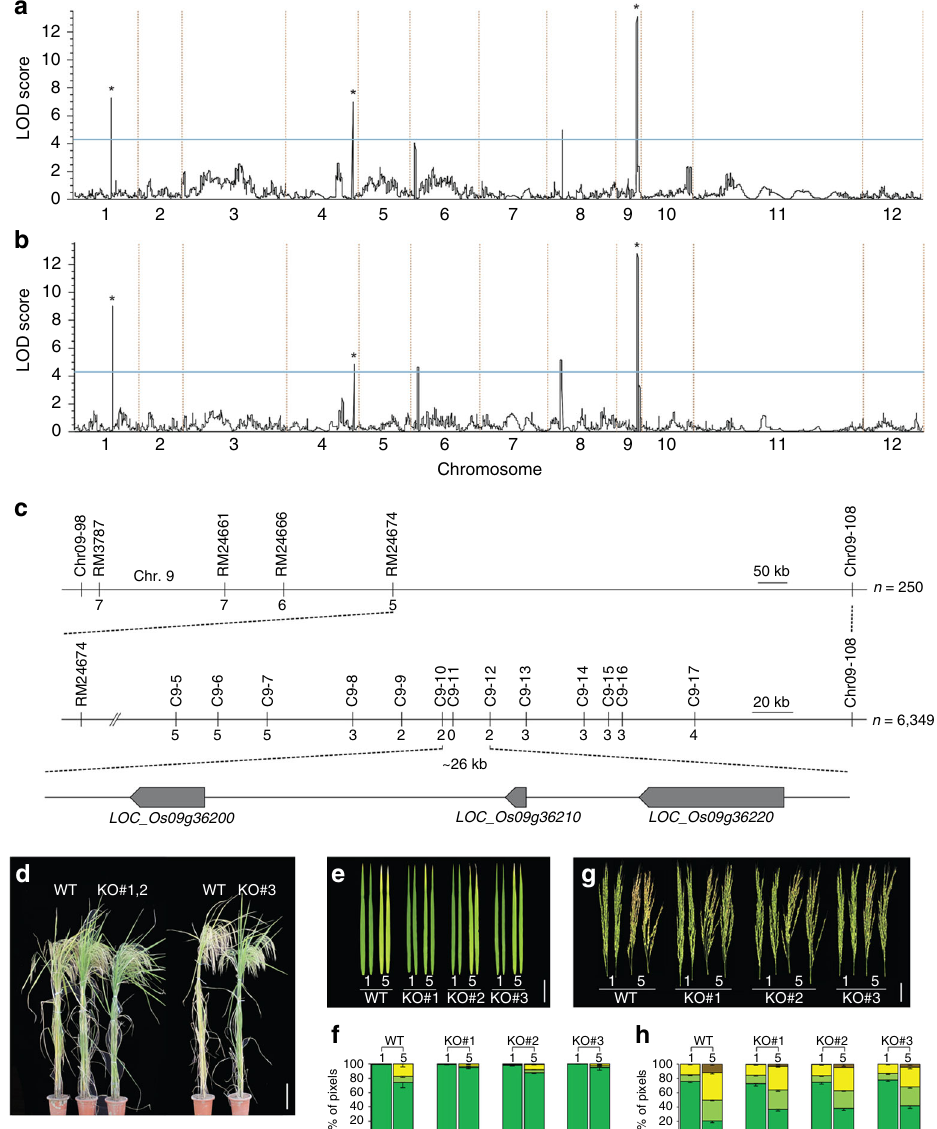
Fig. 2 OsSGR is responsible for the differential leaf senescence. Mapping curves of QTLs controlling the senescence of the fl ag ( a ) and second upper ( b ) leaves on the 12 rice chromosomes via GBS (genotyping-by sequencing). A LOD (log likelihood) signi fi cance threshold of 4.3 (blue lines) was used to declare the presence of signi fi cant QTL in a genomic region. Three common genetic loci between two leaves are indicated as *. c Fine mapping of the locus on the chromosome 9 for the leaf senescence with molecular markers. The 26-kb genomic region between C9 – 10 and C9 – 12 markers contains three predicted coding sequences (thick arrow). d Senescence phenotypes of WT ( indica cultivar Kasalath) and mutants (KO#1, 2, and 3) generated by CRISPR/ Cas9 editing. Scale bar, 20 cm. Color changes ( e , g ) and quanti fi cation ( f , h ) of the fl ag leaves ( e , f ) and panicles ( g , h ) of WT and the indica ossgr mutants during seasonal senescence (1 and 5 weeks after heading). Scale bars, 5 cm. Values are means ± SE ( n ≥ 3). In colourimetric assay, the same scale is used as in Fig. 1. Source data of Fig. 2f and h are provided as a Source Data fi